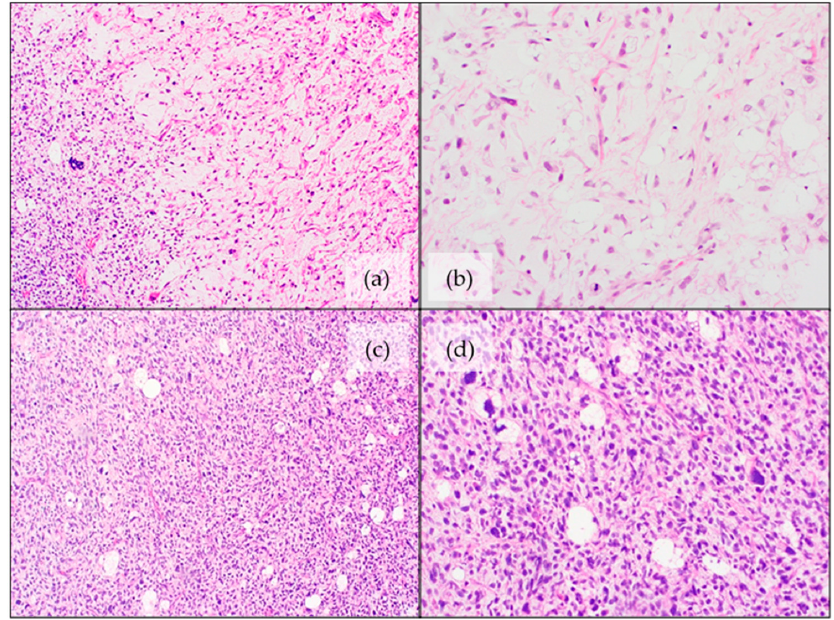
Figure 5. Histopathological features of myxoid pleomorphic liposarcoma: ( a ) Transition from a myx- oid liposarcoma-like area to a pleomorphic liposarcoma-like area (H&E staining); ( b ) Detail image of myxoid liposarcoma-like zone with “chicken-wire” vessels and lipoblasts. There is “at random” atypia and increased mitotic activity (H&E staining); ( c , d ) Overview image and detailed image of pleomorphic liposarcoma-like area with severe cytonuclear atypia and pleomorphic lipoblasts (H&E staining).